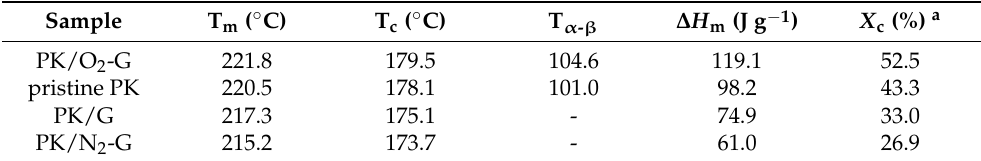
Table 2. DSC data of PK/O 2 -G, pristine PK, PK/G and PK/N 2